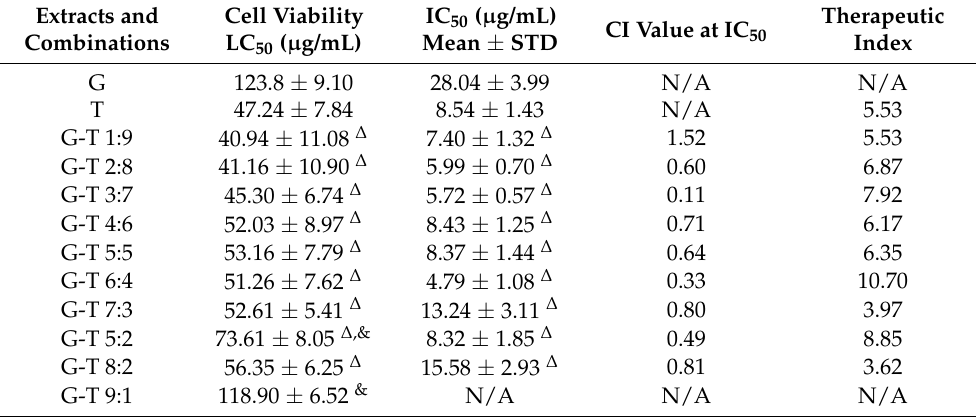
Table 2. Anti-inflammatory, synergistic interaction, therapeutic index and cytotoxicity parameters of ginger and turmeric extracts in inhibiting LPS-induced TNF production in THP-1 cells ( n > 3 of experiments). Therapeutic Extracts and Cell Viability IC 50 ( µ g/mL) CI Value at IC 50 Index Combinations LC 50 ( µ g/mL) Mean ± STD G 123.8 ± 9.10 28.04 ± 3.99 N/A N/A T 47.24 ± 7.84 8.54 ± 1.43 N/A 5.53 G-T 1:9 40.94 ± 11.08 ∆ 7.40 ± 1.32 ∆ 1.52 5.53 G-T 2:8 41.16 ± 10.90 ∆ 5.99 ± 0.70 ∆ 0.60 6.87 45.30 ± 6.74